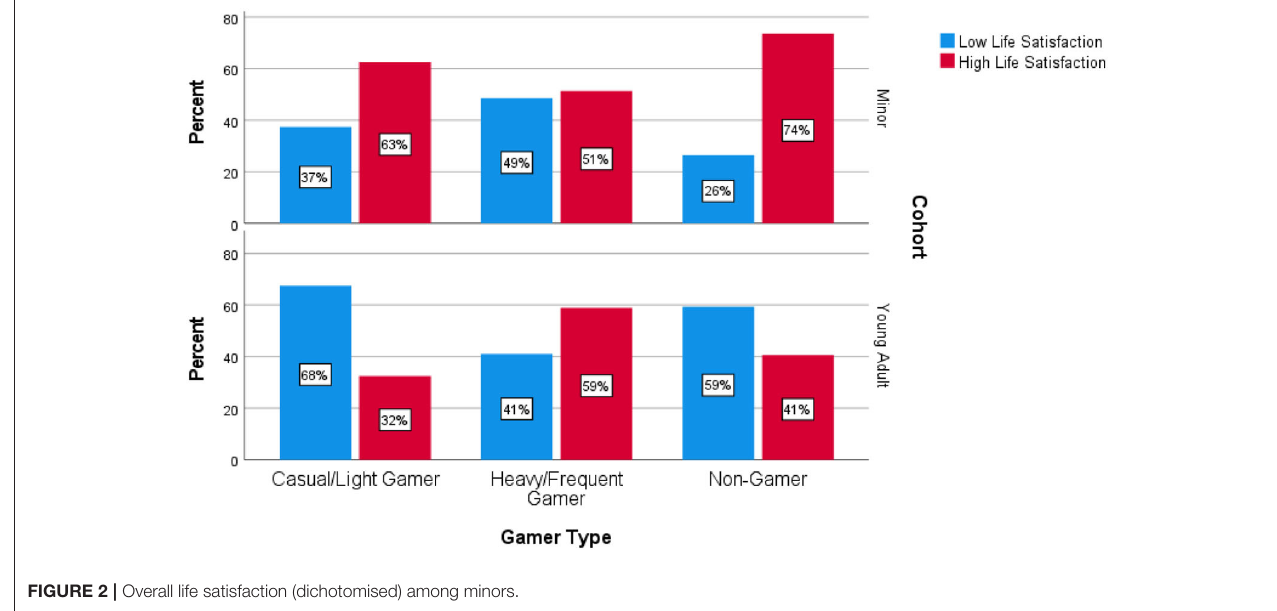
FIGURE 2 | Overall life satisfaction (dichotomised) among minors.